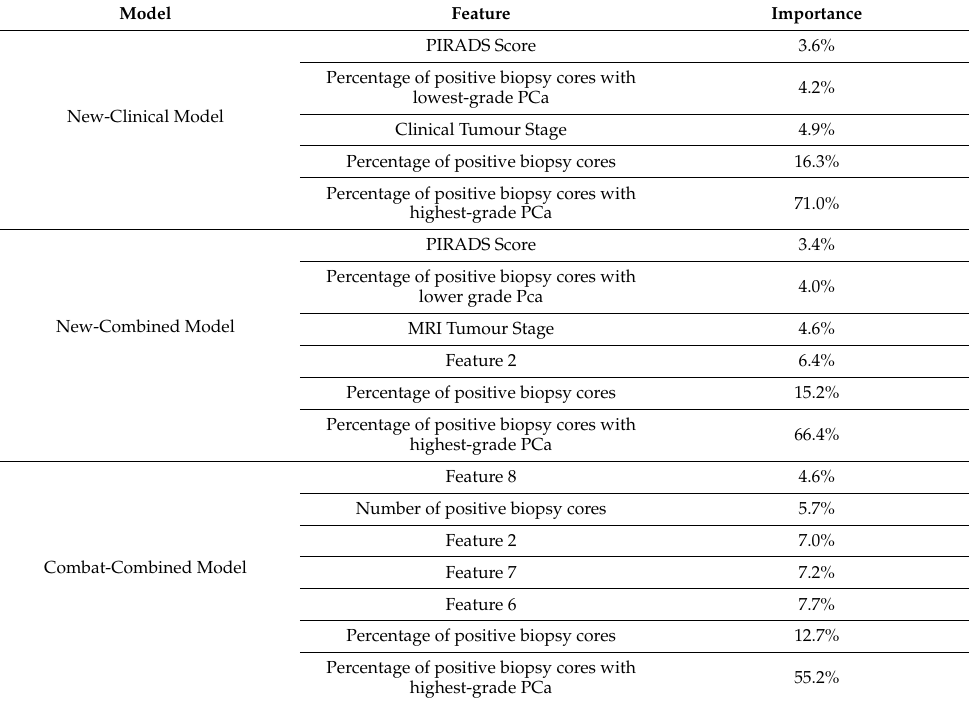
Table 2. Composition of the New-Clinical, New-Combined and Combat-Combined